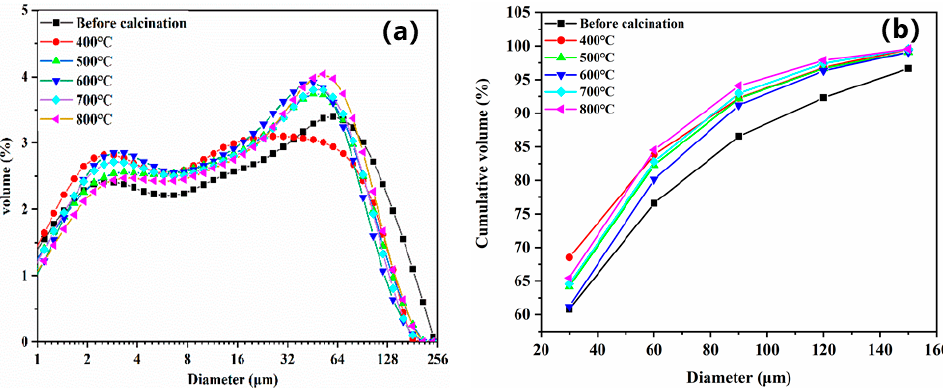
Figure 7. Particle size distribution of magnesium residue at different calcination temperatures: ( a ) particle size distribution, ( b ) cumulative particle size distribution.